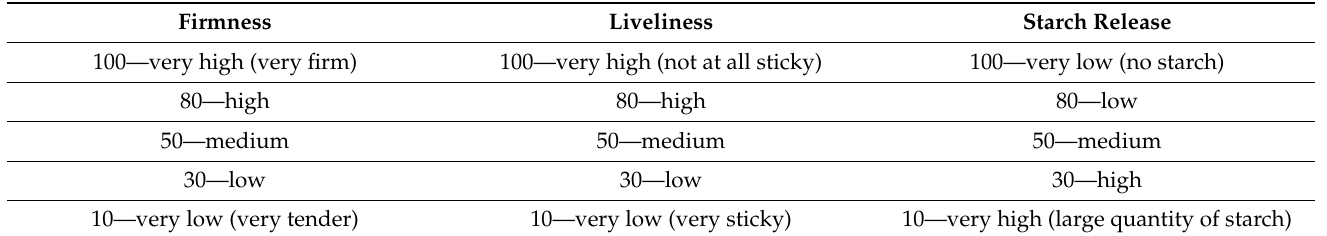
Table 3. Rating scale for pasta sensory analysis